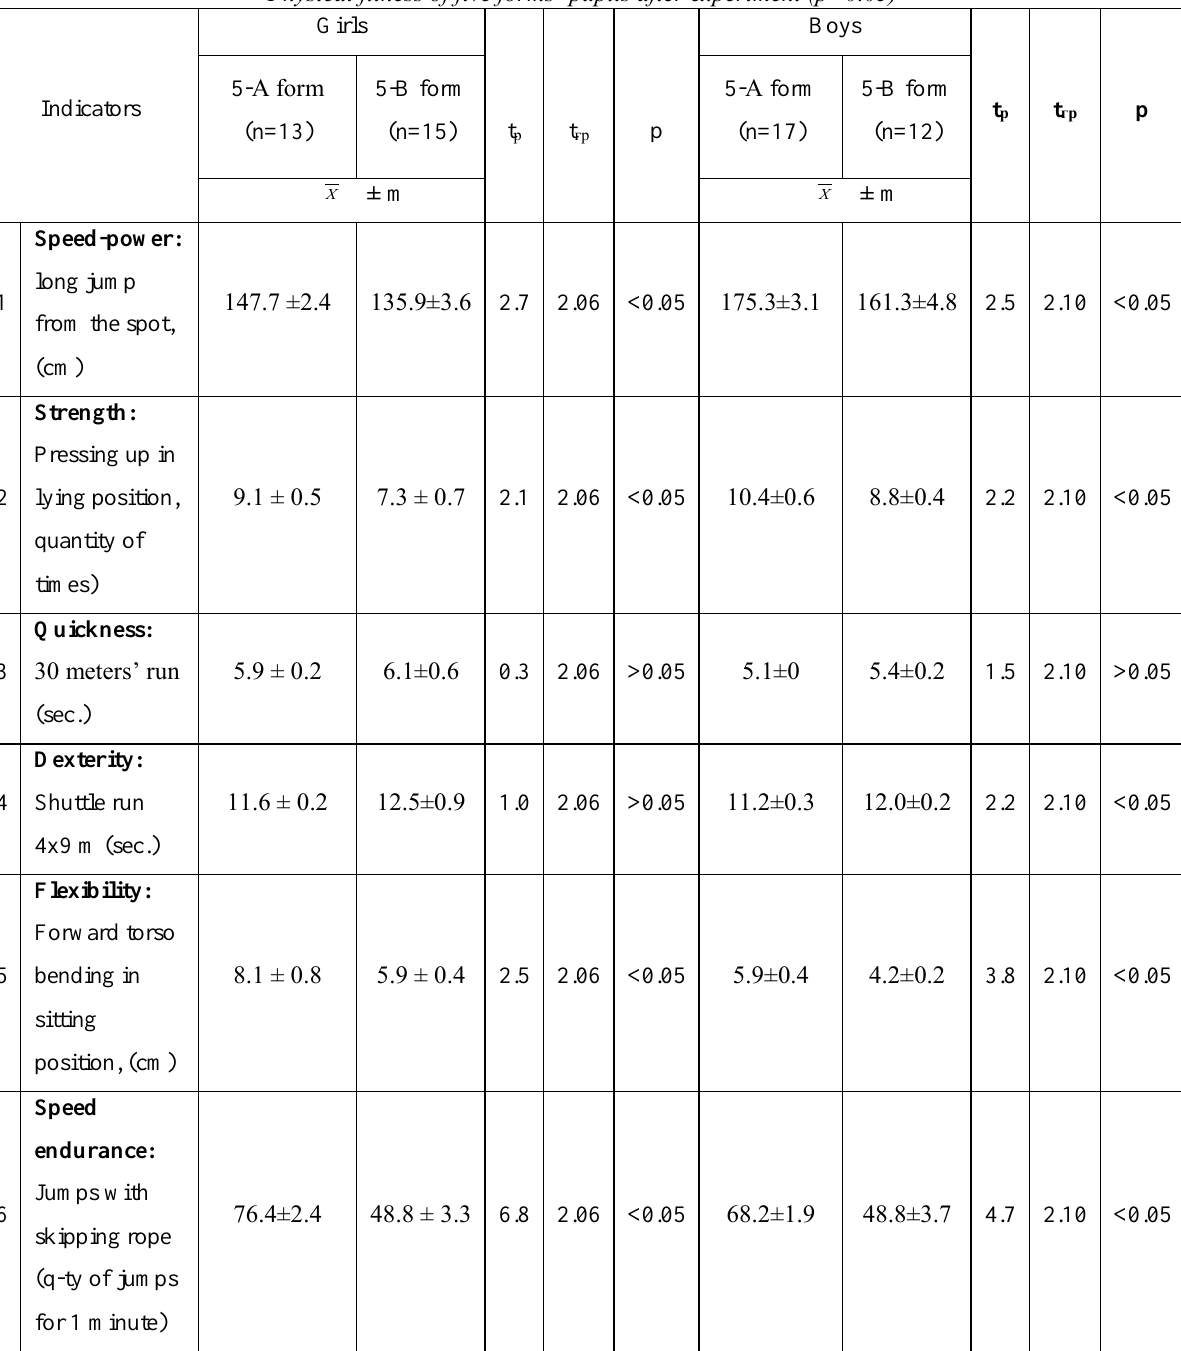
Physical fitness of five forms’ pupils after experiment